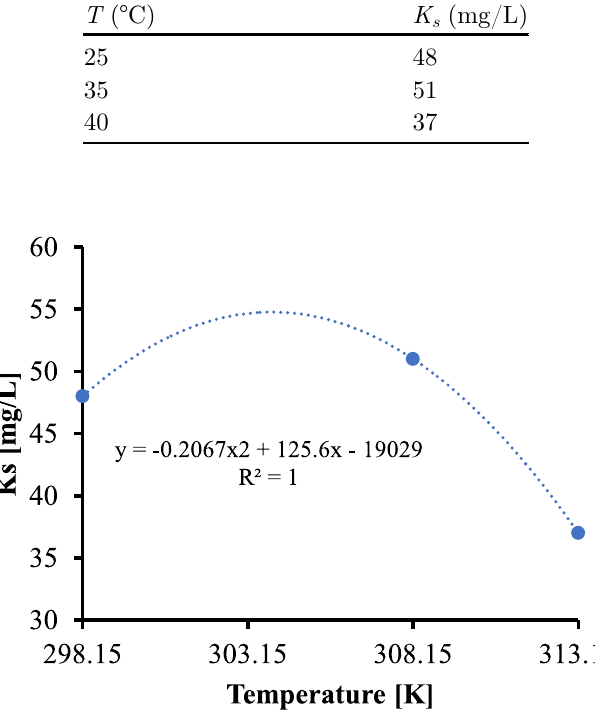
Fig. 5. The effect of temperature on the half saturation coef fi cient ( K s ).